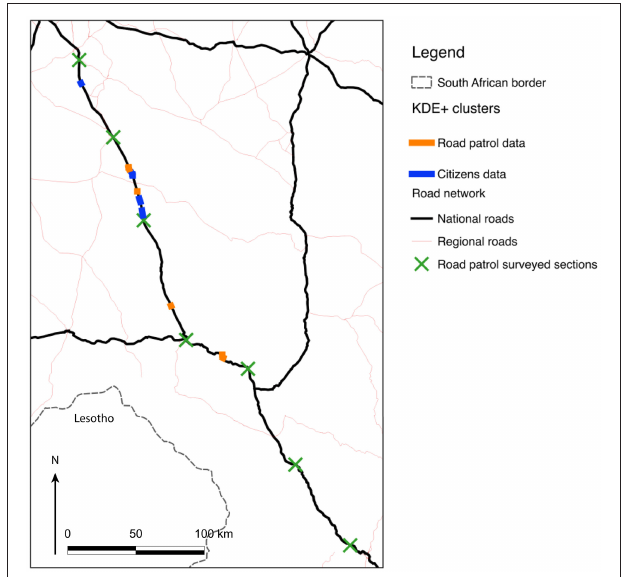
FIGURE 3 | Clusters of roadkill reported on the N3 identified from the road patrol (orange) and citizens (blue) reports using KDE + method. Only clusters with a strength superior to 0.4 are shown.